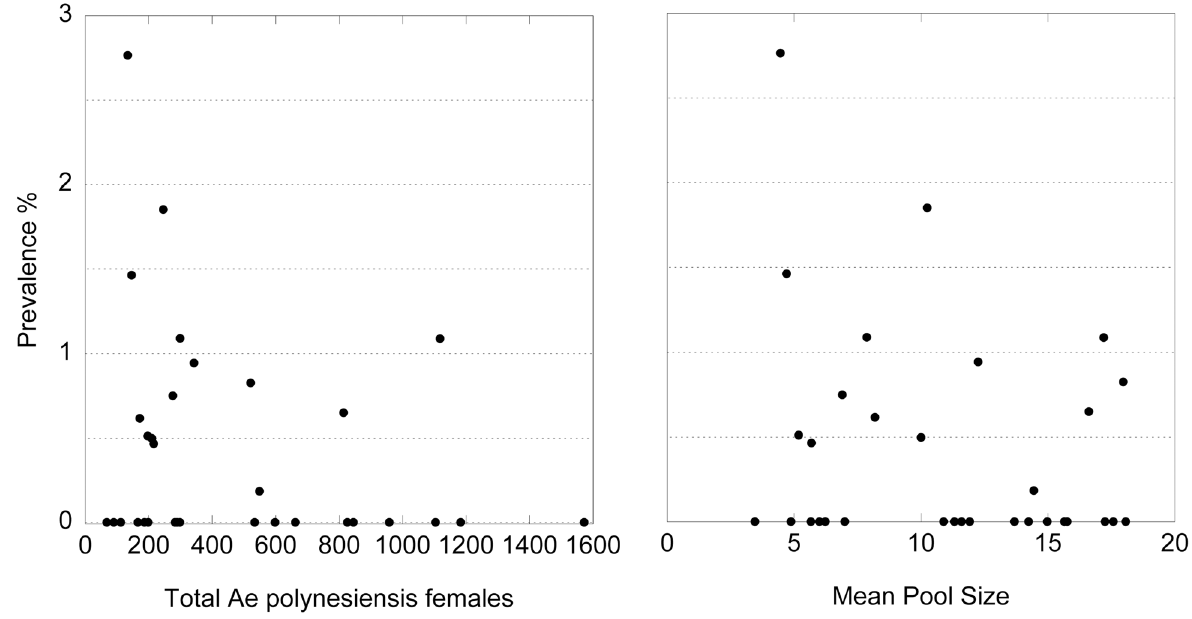
Figure 5. Estimated prevalence of Ae.polynesiensis containing W.bancrofti DNA for each village versus total Ae.polynesiensis females tested (left) and mean pool size (right).